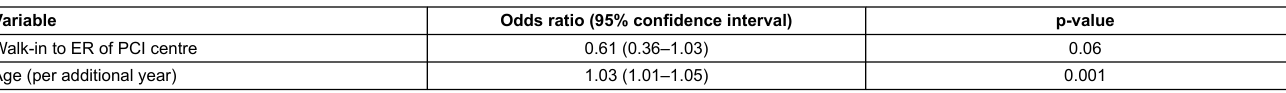
Table 2: Predictors for first medical contact to revascularisation >90 minutes.